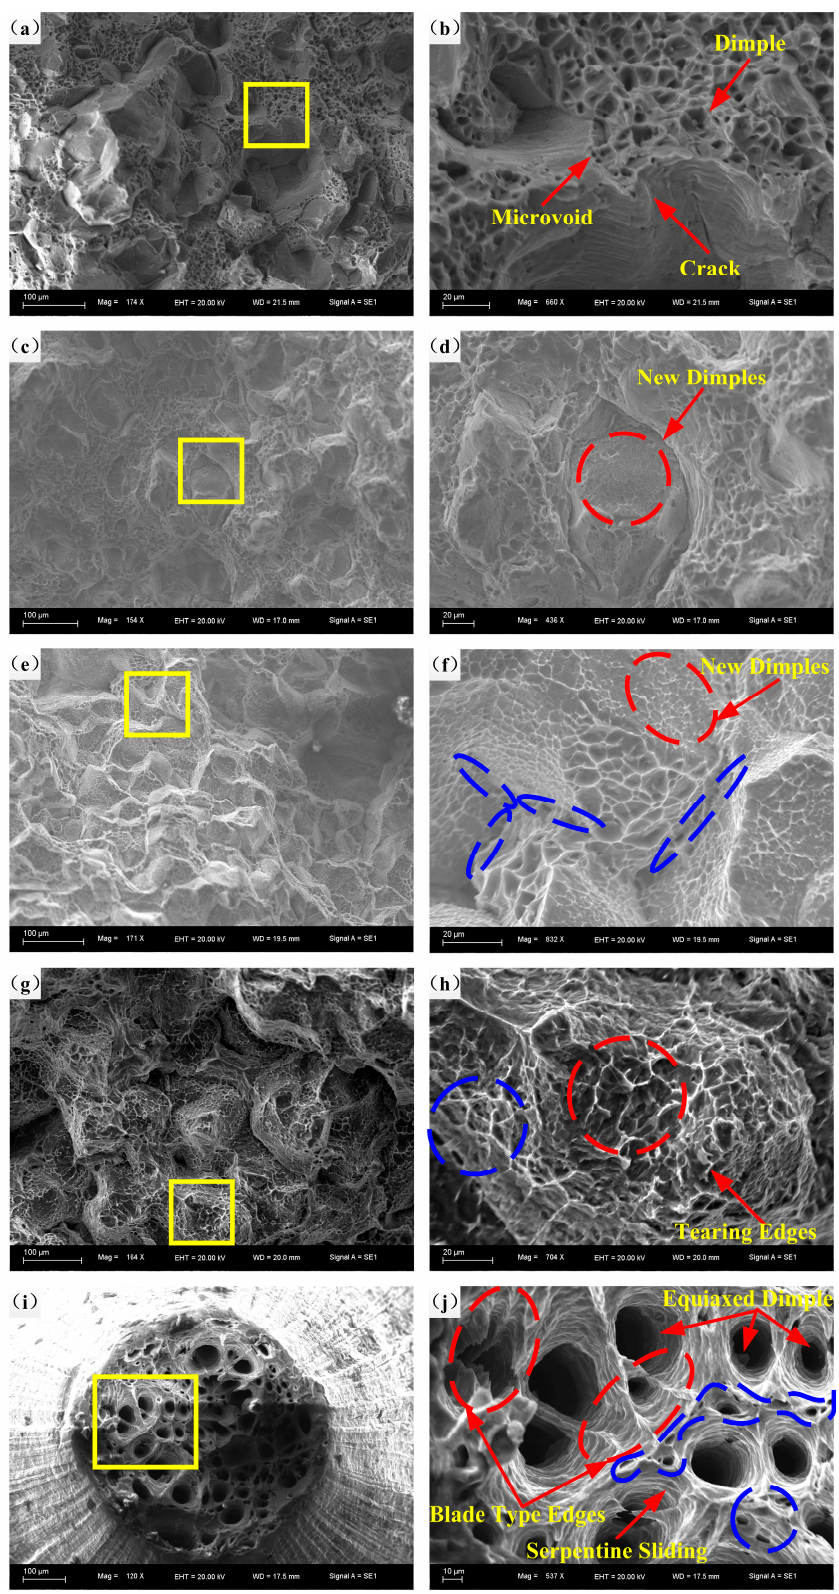
Figure 10. Fracture morphologies at strain rate of 10 − 4 s − 1 and temperatures of: ( a , b ) RT; ( c , d ) 100 °C; ( e , f ) 200 °C; ( g , h ) 300 °C and ( i , j ) 400 °C.